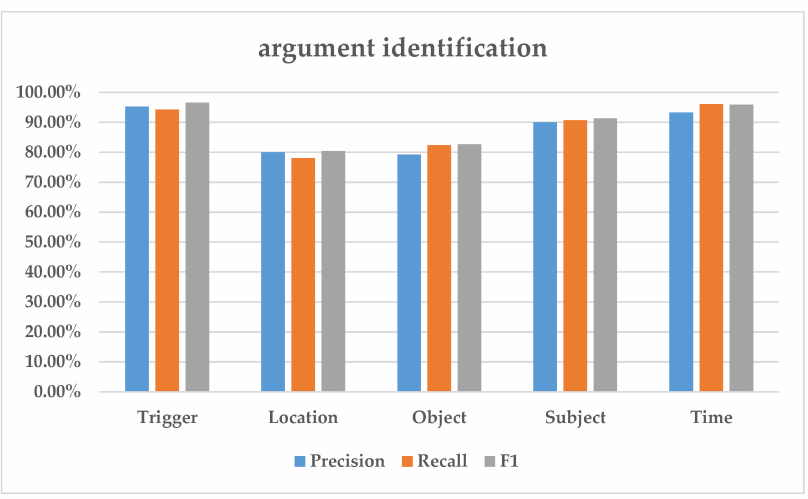
Figure 5. The results of argument